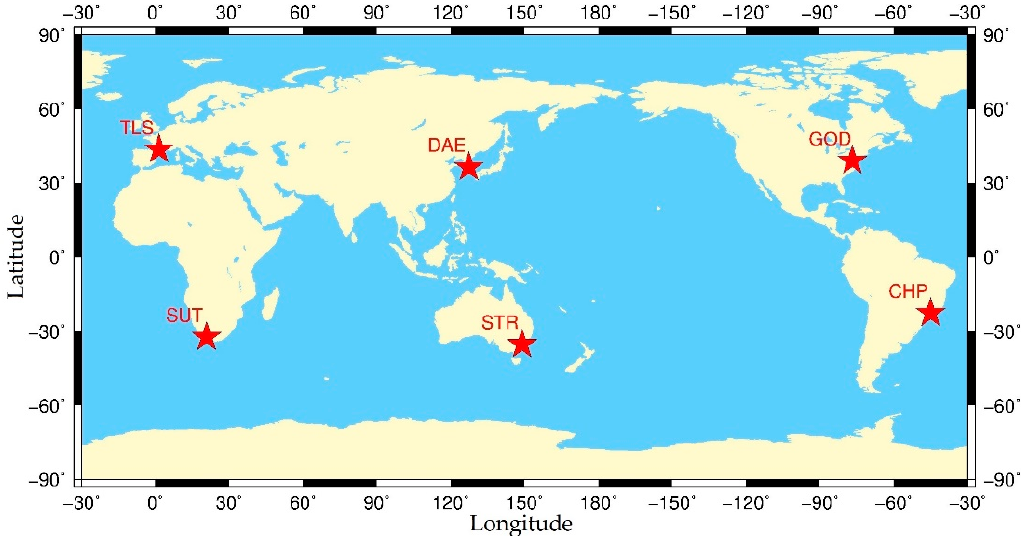
Figure 2. Locations of six independent baselines with co-located International GNSS Service (IGS) stations.